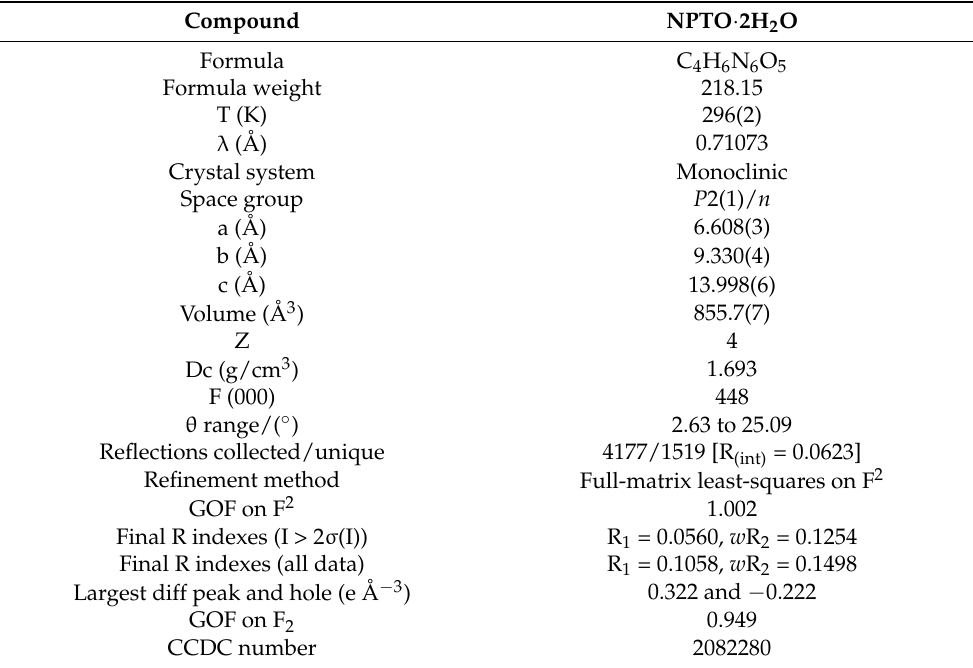
Table 1. Crystallographic details of NPTO · 2H 2